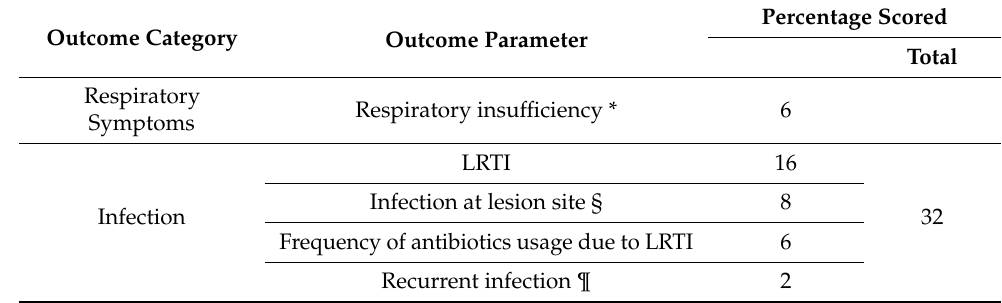
Table 4. Outcome parameters scored as most important for determining the optimal management of asymptomatic CPAM